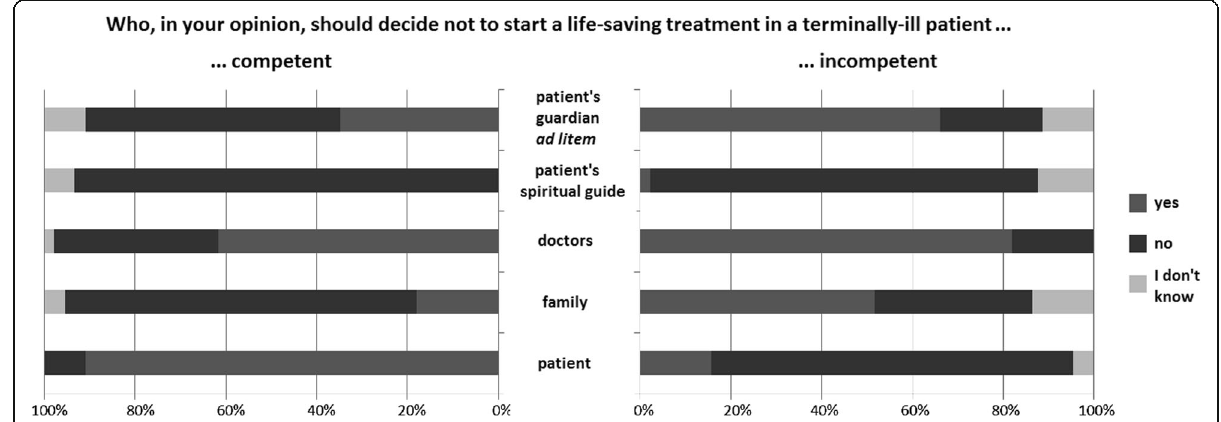
Fig. 2 Graph of Life-saving treatment answeres. Legend: Percentage of answeres related to terminal patient (competent and